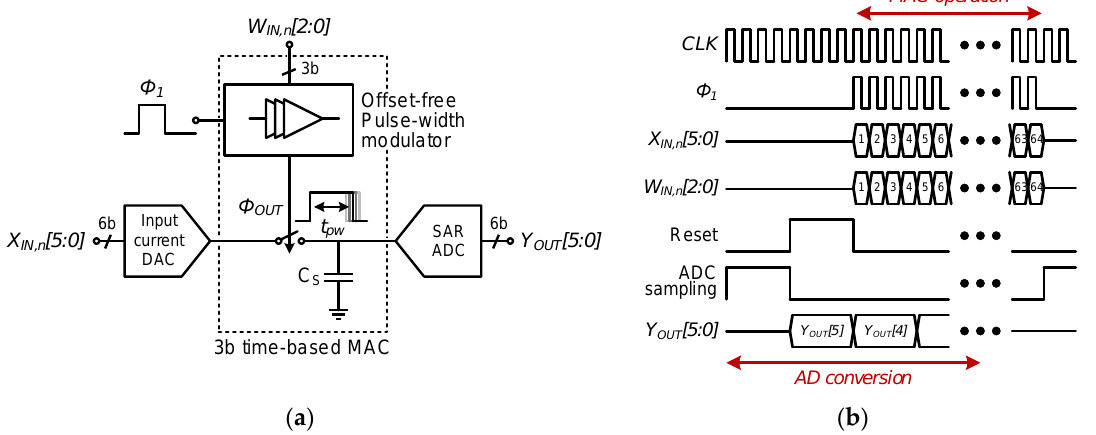
Figure 4. Proposed time-based matrix multiply-and-accumulate (MAC): ( a ) system architecture and ( b ) timing diagram.